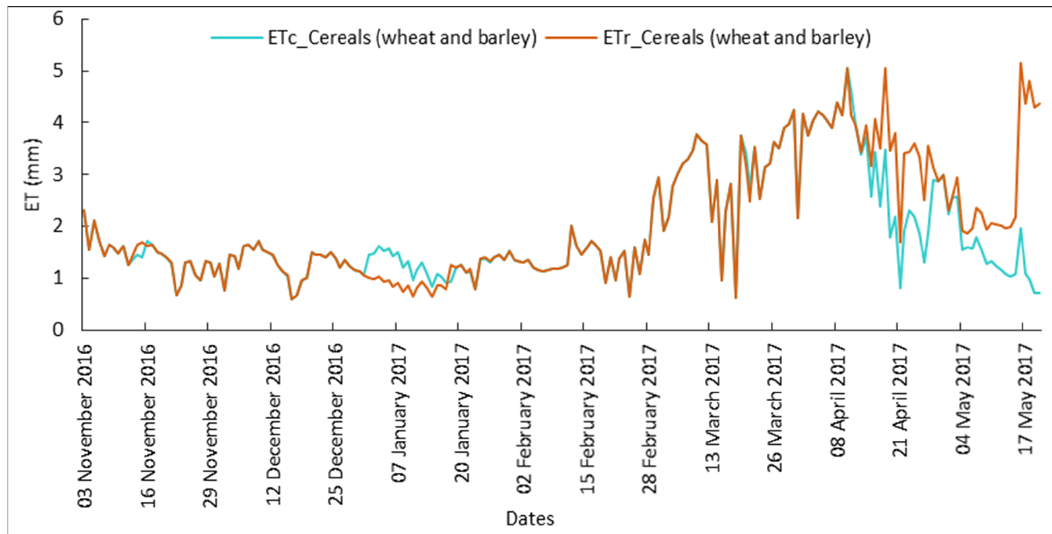
Figure 14. Comparison between ETc and ETr for cereal crops (wheat and barley).